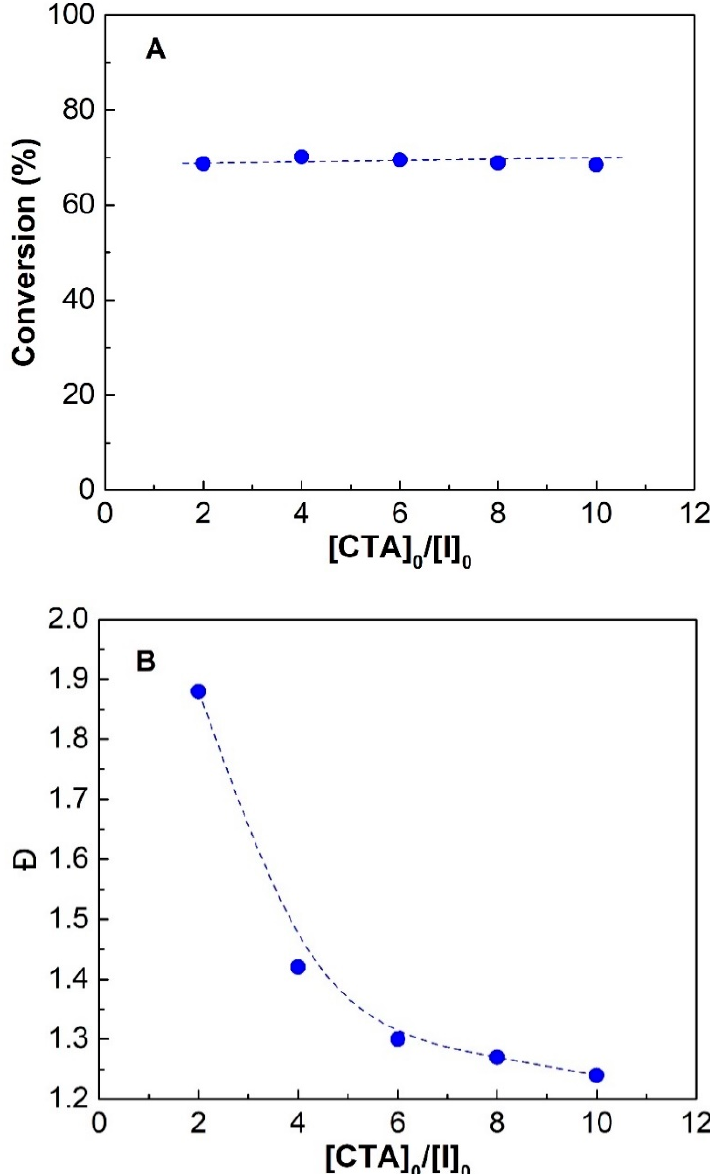
◦ C, 200 r min –1 , T = 70 ◦